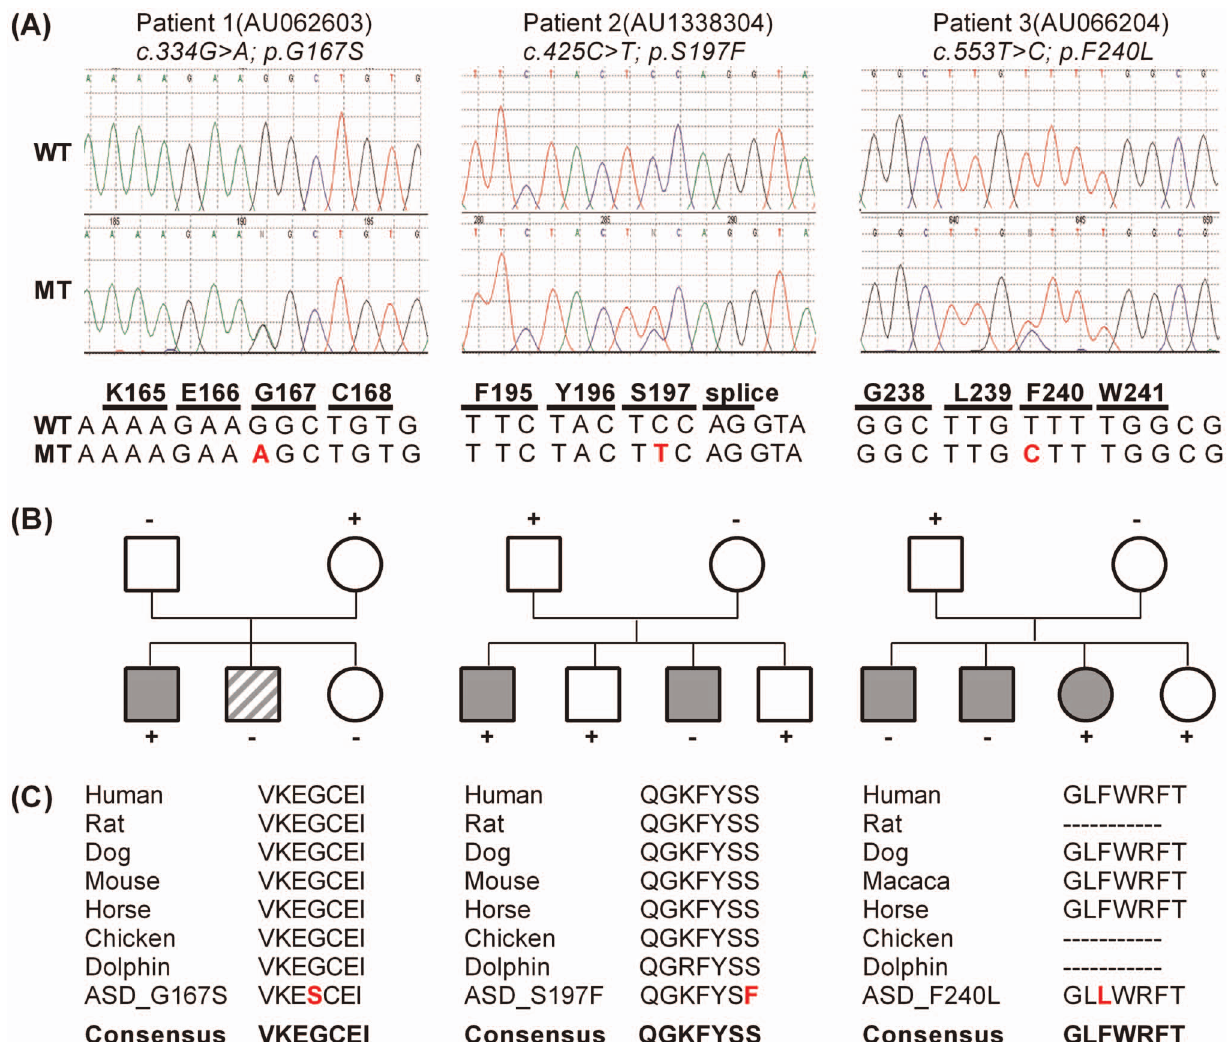
Figure 2. ( a ) Chromatogram showing point mutations for patient 1–3. ( b ) The pedigrees show the occurrence of the disease phenotype and the inheritance of missense mutations in CACNB2 . Circles and squares indicate females and males, respectively. Filled symbols denote diagnosis of autism; partially filled symbols denote individuals that are diagnosed within a broad spectrum of pervasive developmental disorders. ( c ) Alignments show conservation among different species for p.G167S, p.S197F and p.F240L suggesting an importance for the topology and